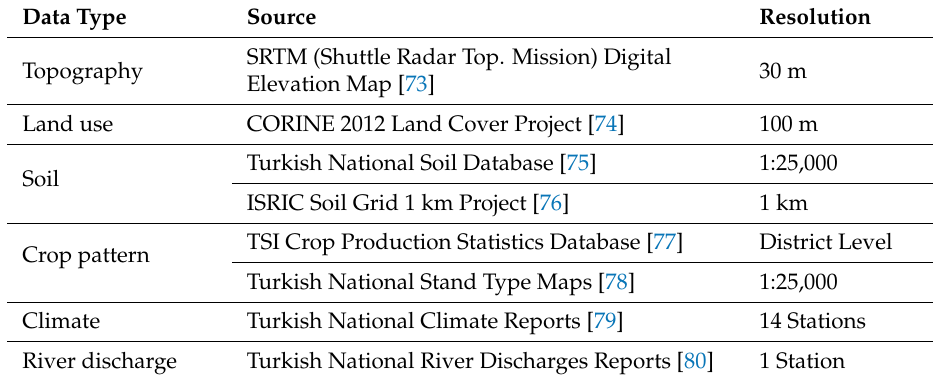
Table 1. Data type, source, and resolution used in this study.